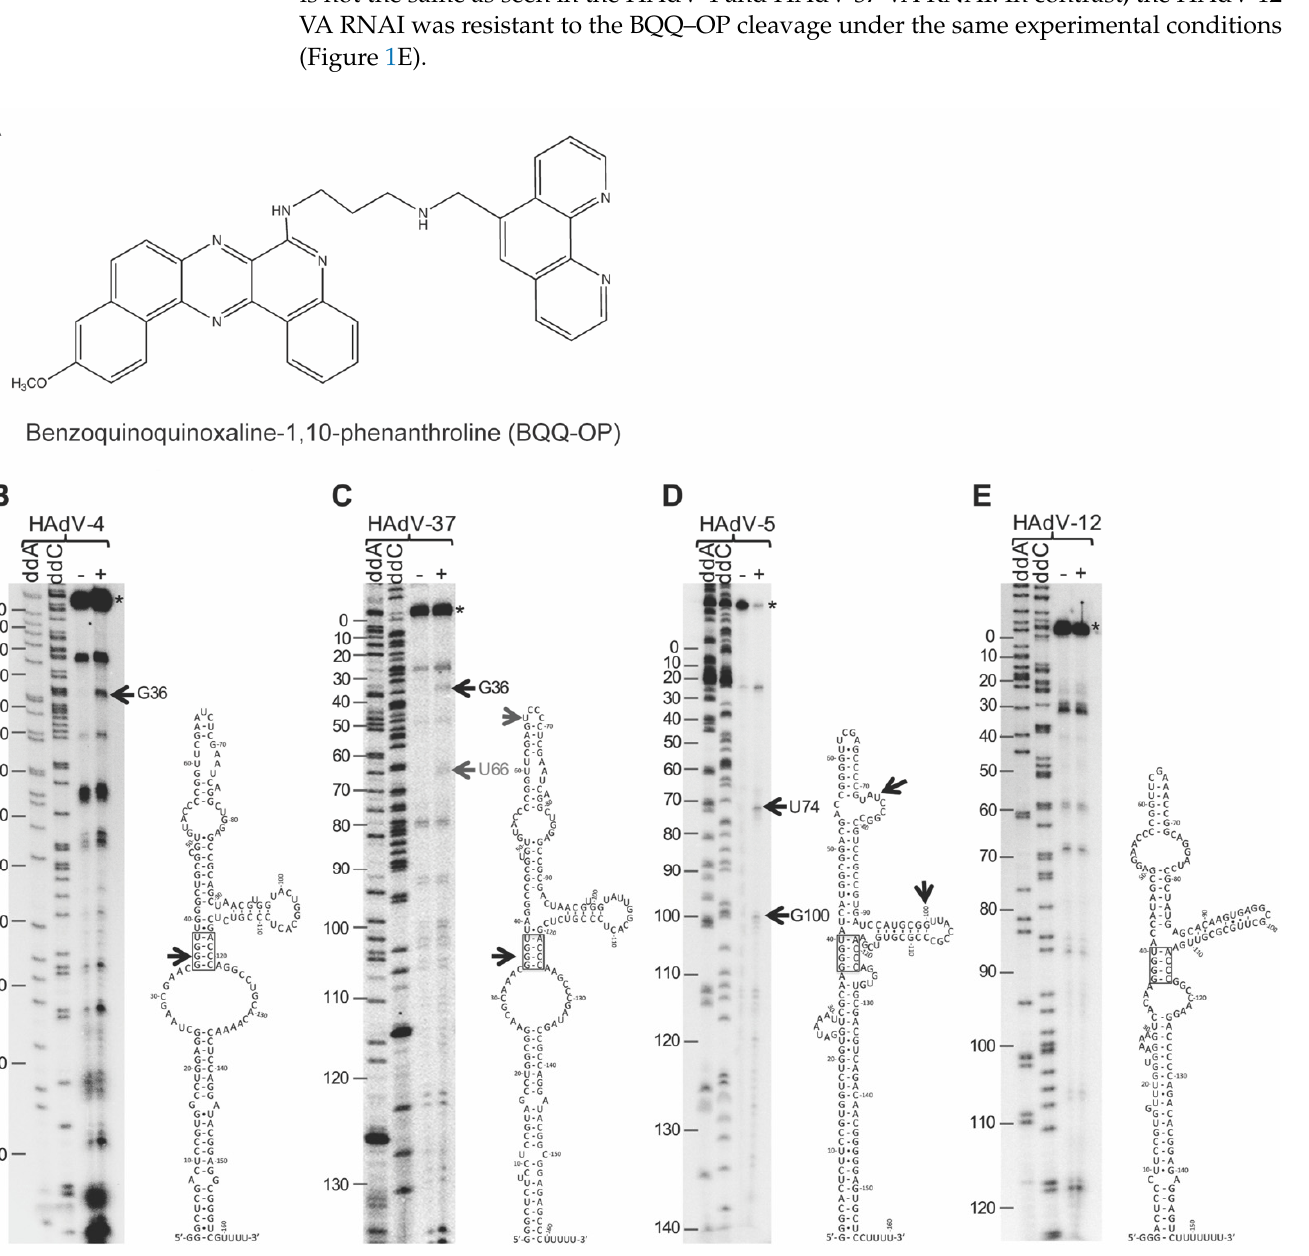
Figure 1. Differential cleavage of HAdV-4, HAdV-37, HAdV-5, and HAdV-12 VA RNAI by BQQ–OP. ( A ) Structure of the benzoquinoquinoaxline 1, 10-phenanthroline (BQQ–OP). Differential cleav- age of 32 P-labelled VA RNAI from HAdV-4 ( B ), HAdV-37 ( C ), HAdV-5 ( D ), and HAdV-12 ( E ) by BQQ–OP. The schematic secondary structure models of HAdV-4, HAdV-12, and HAdV-37 VA RNAI were derived from [28], whereas the schematic structure of HAdV-5 is from [33]. The hyphen (-) indicates incubation without BQQ–OP, whereas the plus (+) shows incubation in the presence of BQQ–OP. The horizontal arrows point towards specific VA RNAI cleavage products. The asterisk (*) marks the full-length, uncleaved VA RNAI. Sanger sequencing reactions with dideoxynucleo- tides (ddC and ddA) on the HAdV-4, HAdV-37, HAdV-5, and HAdV-12 VA RNAI containing plas- mids were used for VA RNAI nucleotide numbering from 5 ′ to 3 ′ . 2.2. BQQ–OP Cleavage Specificity of the HAdV-4 VA-RNAI Based on the established BQQ–OP reactivity and specificity for triplex DNA [11,13], we hypothesized that the observed VA RNAI cleavage by the BQQ–OP (Figure 1B) indi- cates a potential triplex structure formation within the HAdV-4 VA RNAI molecule. DNA–DNA or DNA–RNA triplex structures are formed by the hydrogen-bonding be- tween the Watson–Crick base-paired polypurine/polypyrimidine double-strand se- quences and either a pyrimidine-rich or a purine-rich third strand via Hoogsteen or re- verse Hoogsteen base-pairing [4,34]. The closer inspection of the HAdV-4 VA RNAI